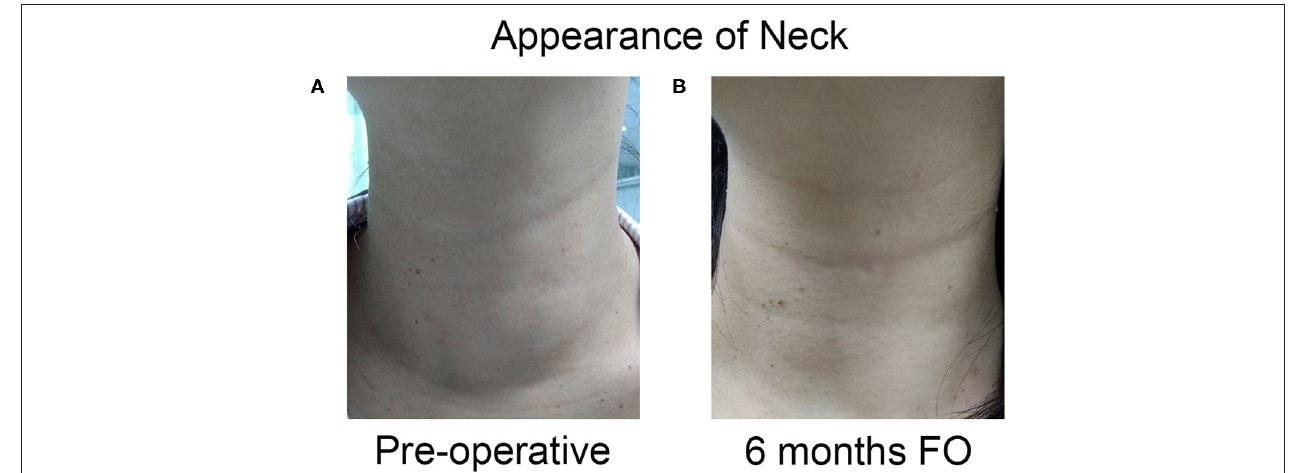
FIGURE 6 | The appearance of neck complaint resolved completely after one session of US-guided RFA. (A) The appearance of the neck had a cosmetic score of 4 pre-operation. (B) The patient had a good cosmetic score at 6 months after